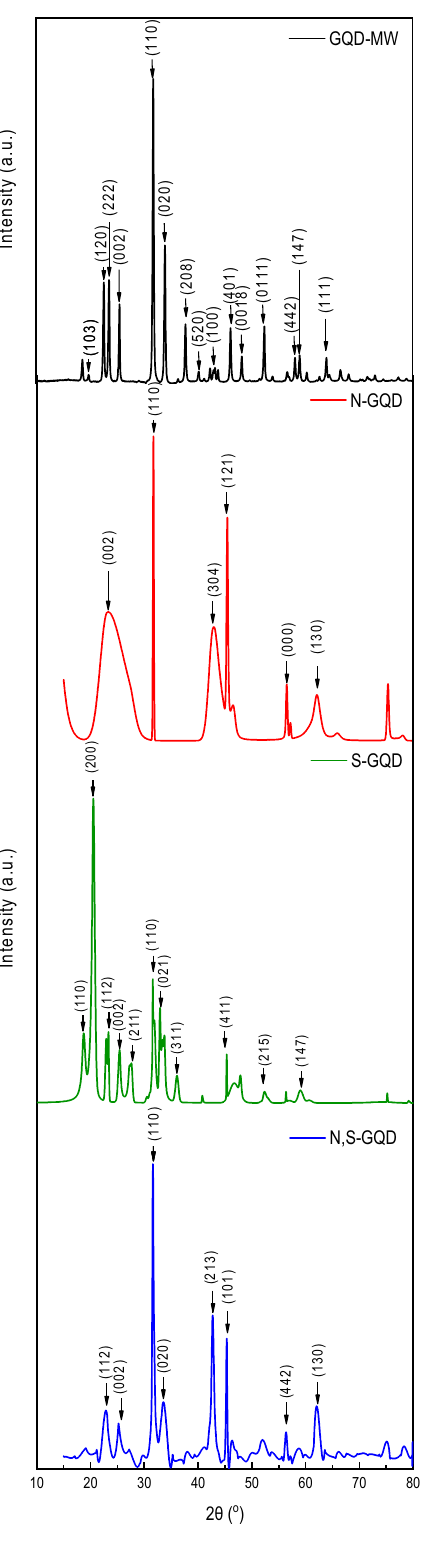
Figure 1. Comparison of the Powder XRD patterns of Pristine, S-doped, N-doped, and N,S co-doped GQDs. XRD patterns were taken from 15 to 80° at a scan rate of 1° per